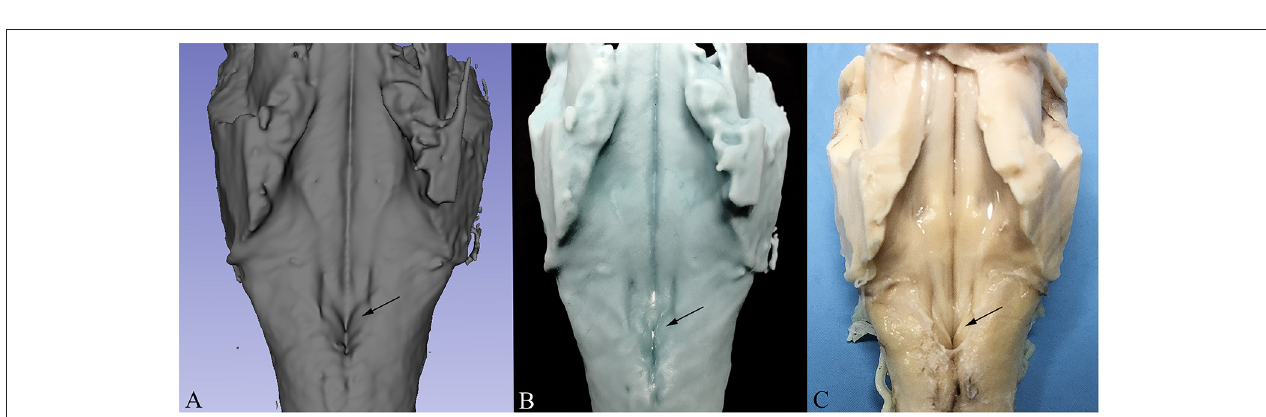
FIGURE 6 | Comparison between 3D Reconstruction (A) , 3D Print based on the reconstructed model (B) and the real specimen prior to sectioning (C) . The arrow indicates the Vagal Trigone in all three images.